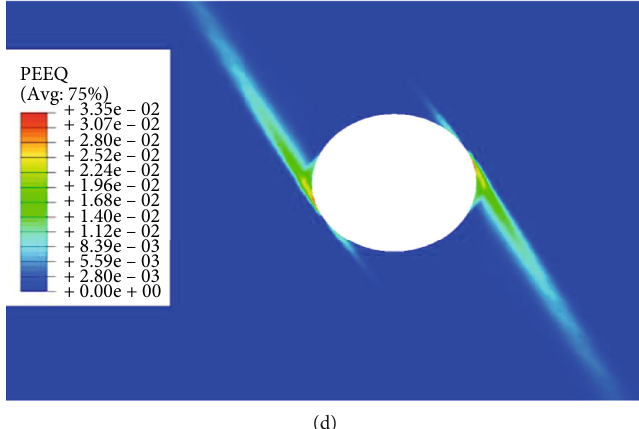
Figure 22: Damage zone around the wellbore (a) without considering the bedding planes and microcracks, (b) considering the bedding planes and microcracks without strength degradation and pore pressure change, (c) considering the bedding planes and microcracks with pore pressure change but no strength degradation, and (d) considering the bedding planes and microcracks with both strength degradation and pore pressure